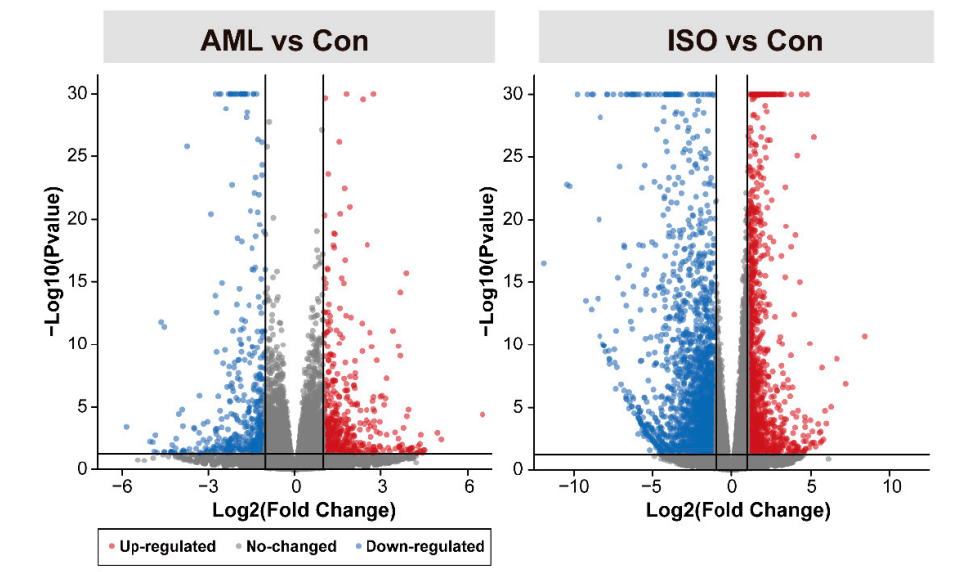
Figure 2. Volcano plots of all quantified genes in the transcriptome analysis of zebrafish embryos with AML ( left ) and ISO ( right ) exposure compared to the control. Each plotted point represents the association results for an individual gene. Significantly differentially expressed genes are defined as those with at least ± 2-fold change (level of magnitude, vertical lines) and Benjamini and Hochberg adjusted p <0.05 (level of statistical significance, horizontal line) and illustrated in red (increased expression) or blue (decreased expression). In order to make the figures more readable, adjusted p value which was <1 × 10 − 30 was modified to 1 × 10 − 30